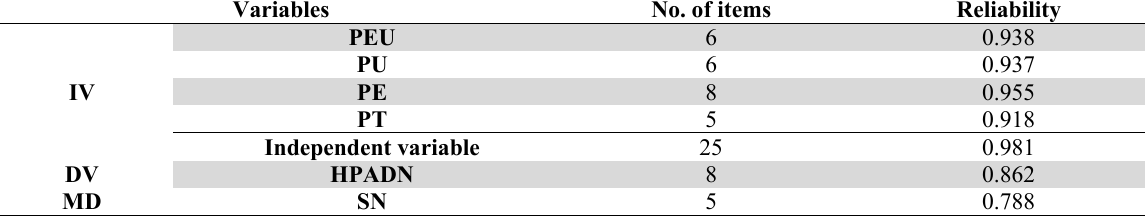
Reliability analysis (Cronbach’s Alpha) results for all research variables